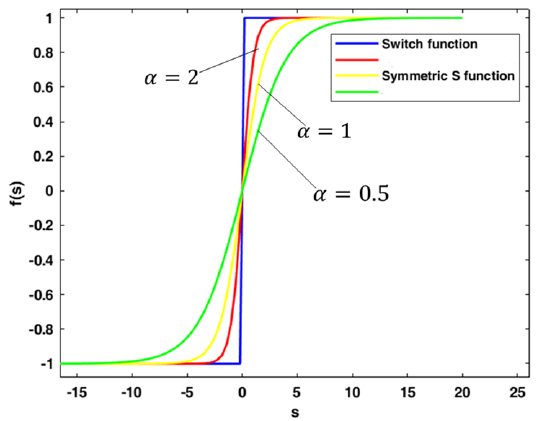
Figure 2. Switch function and symmetric S-type function. Therefore, the new reaching law based on the symmetric S-type function is shown in Equation (15), where ε > 0, k > 0, a , b ∈ [ 0, 1 ] , and α =